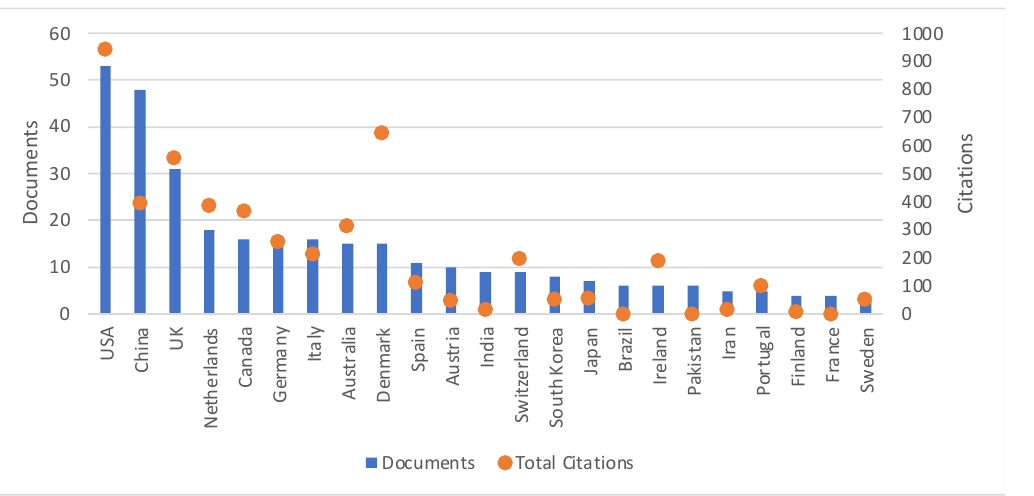
Figure 3. Country * scientific production and citation. * Only countries with more than 3 papers are listed. Source: Authors’ own elaboration .